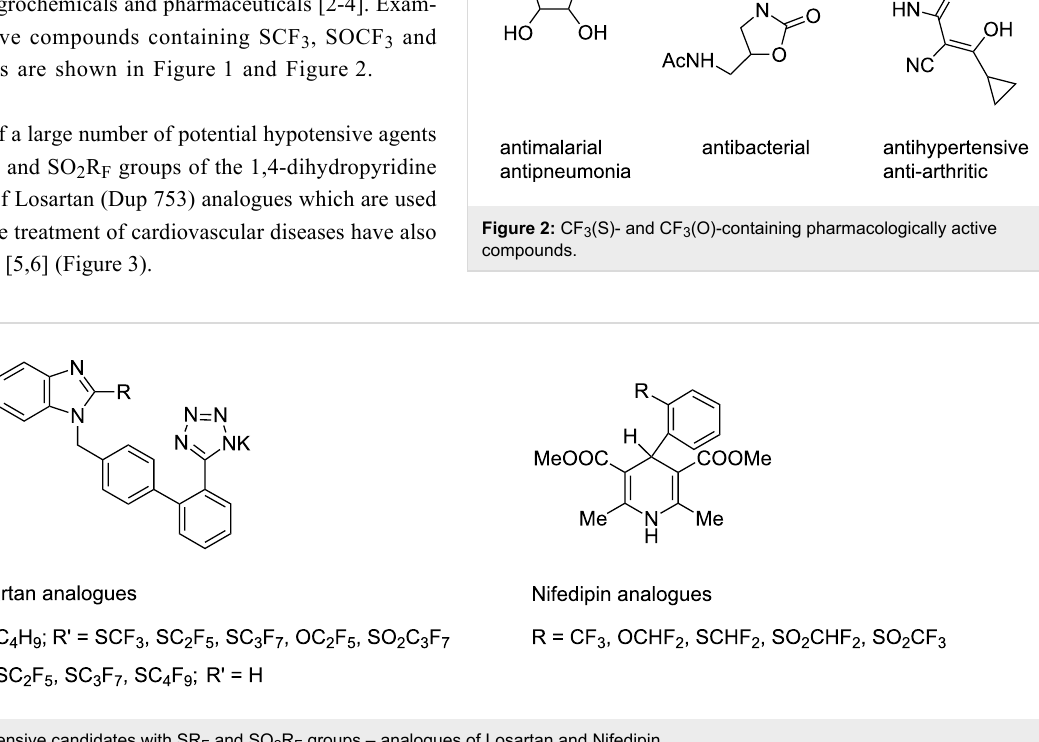
Figure 3: Hypotensive candidates with SR F and SO 2 R F groups – analogues of Losartan and Nifedipin.